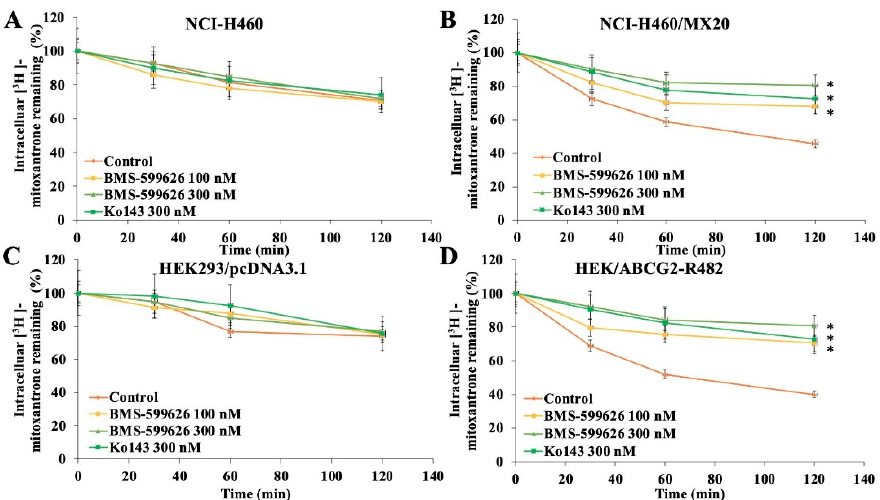
Figure 5. E ff ect of BMS-599626 on the e ffl ux of [ 3 H]-mitoxantrone. The time course (0, 30, 60 and 120 min) vs. percent of intracellular [ 3 H]-mitoxantrone in ( A ) NCI-H460 cells, ( B ) NCI-H460 / MX20 cells, ( C ) HEK293 / pcDNA3.1 cells, and ( D ) HEK / ABCG2-R482 cells. Ko143 was used as a positive control. Mean values from three independent experiments are given and error bars indicate SD. (*) indicates p < 0.05 compared to control